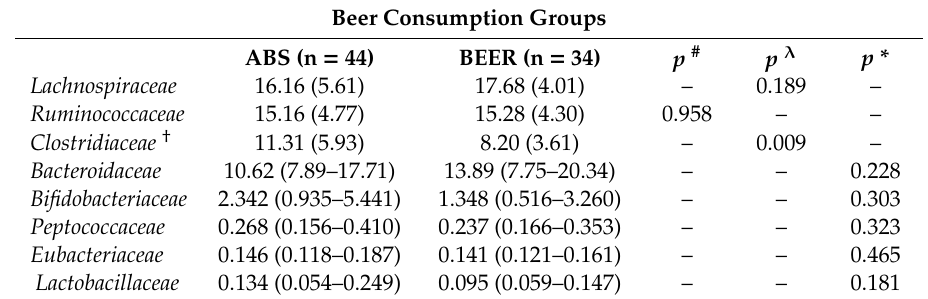
Table 2. Relative abundances [%] of bacterial families in moderate beer consumers and Table 2 . Relative abundances [%] of bacterial families in moderate beer consumers and abstainers.